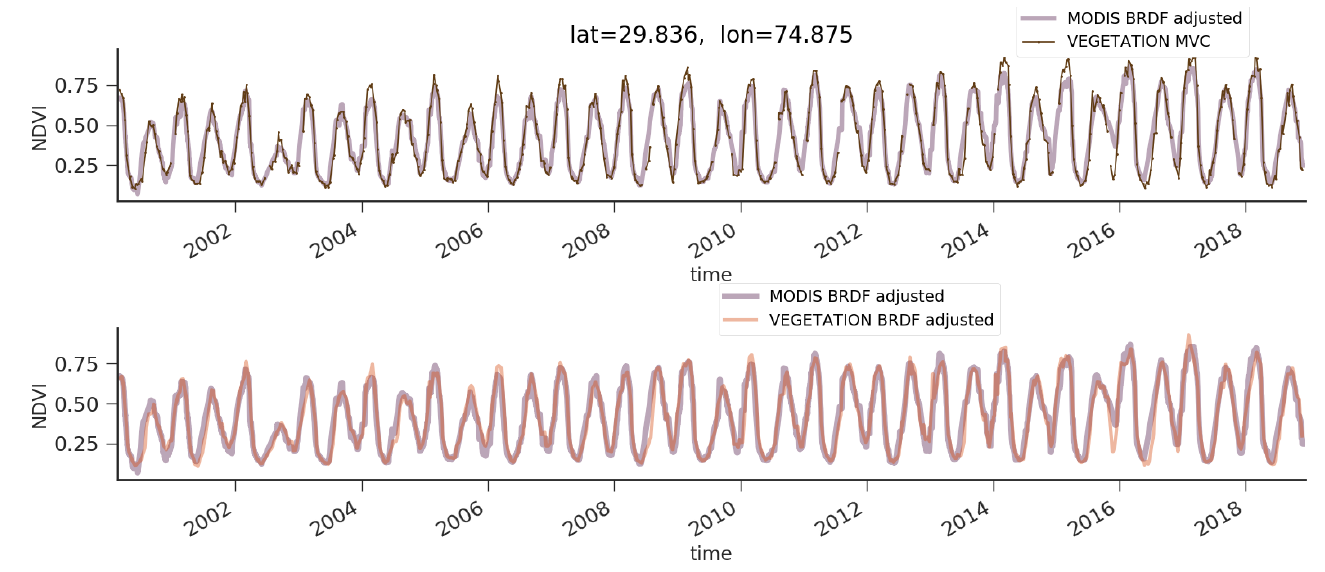
Figure 11. Same layout as in Figure 10 but for Belmanip 332